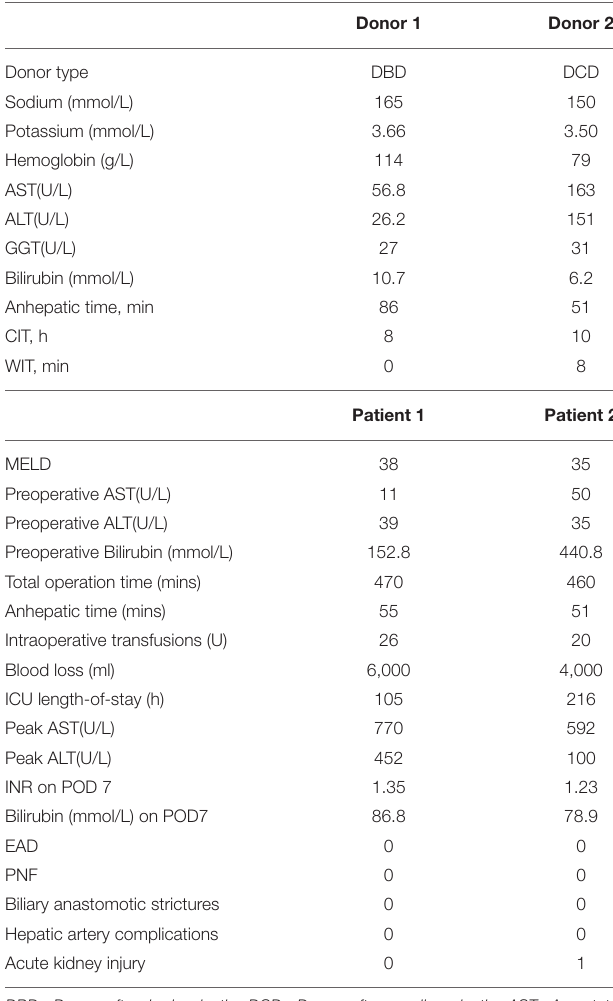
TABLE 2 | Perioperative data of 2 patients with continuous NMP without